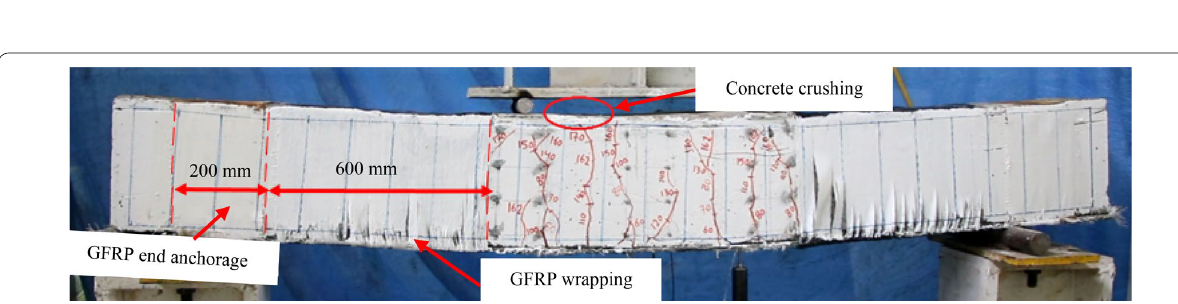
Fig. 16 Failure mechanism and details of failure mode of R3DTRB specimen.